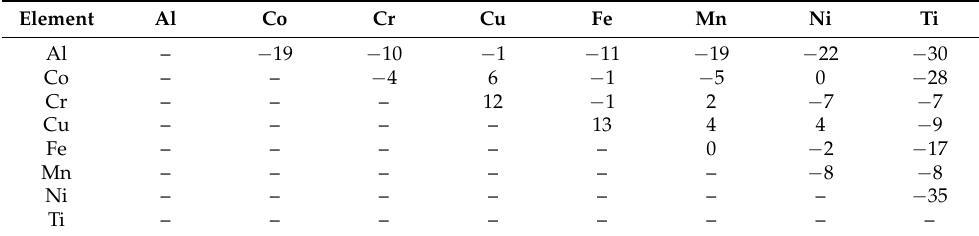
of different elements in high-entropy alloys (kJ/mol) [28]. AB